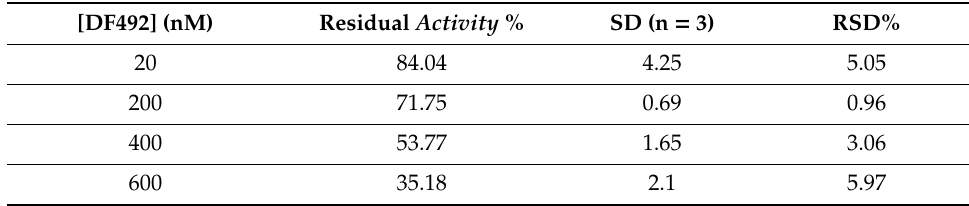
Table 4. Residual enzymatic activity % calculated by adding di ff erent solutions at increasing concentrations of DF492, as inhibitor.